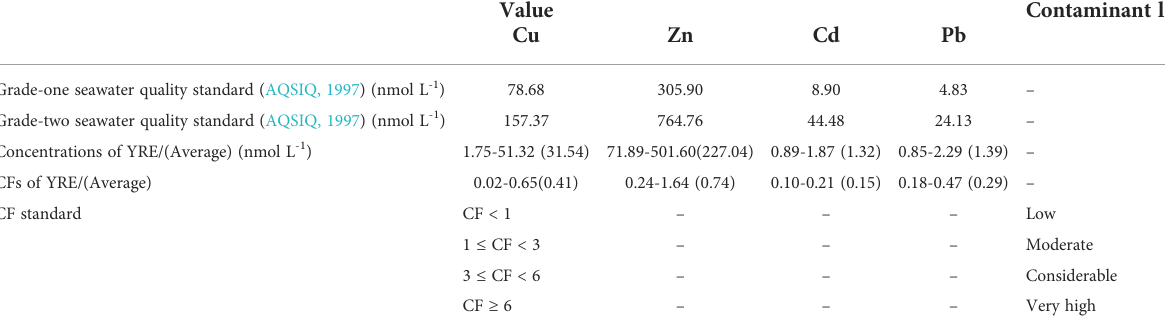
TABLE 1 The summary of the CF values of the sampling sites and seawater standard. Standard values were interpreted as recommended by Hakanson (1980) and Lü et al.